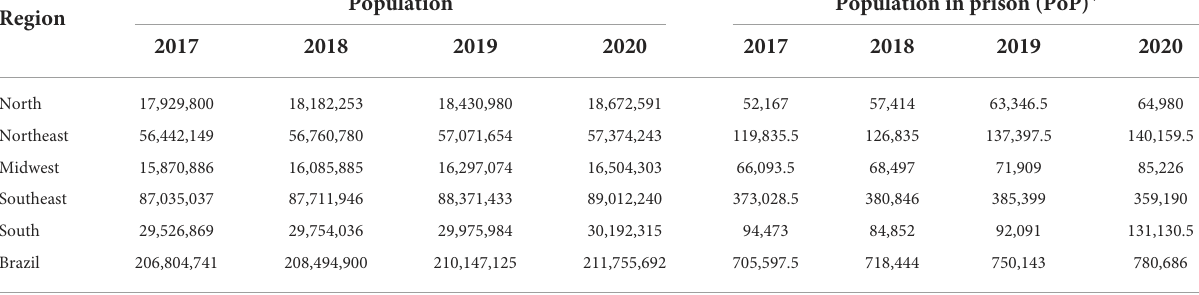
TABLE 2 Population of Brazil and the prison system per region and year.